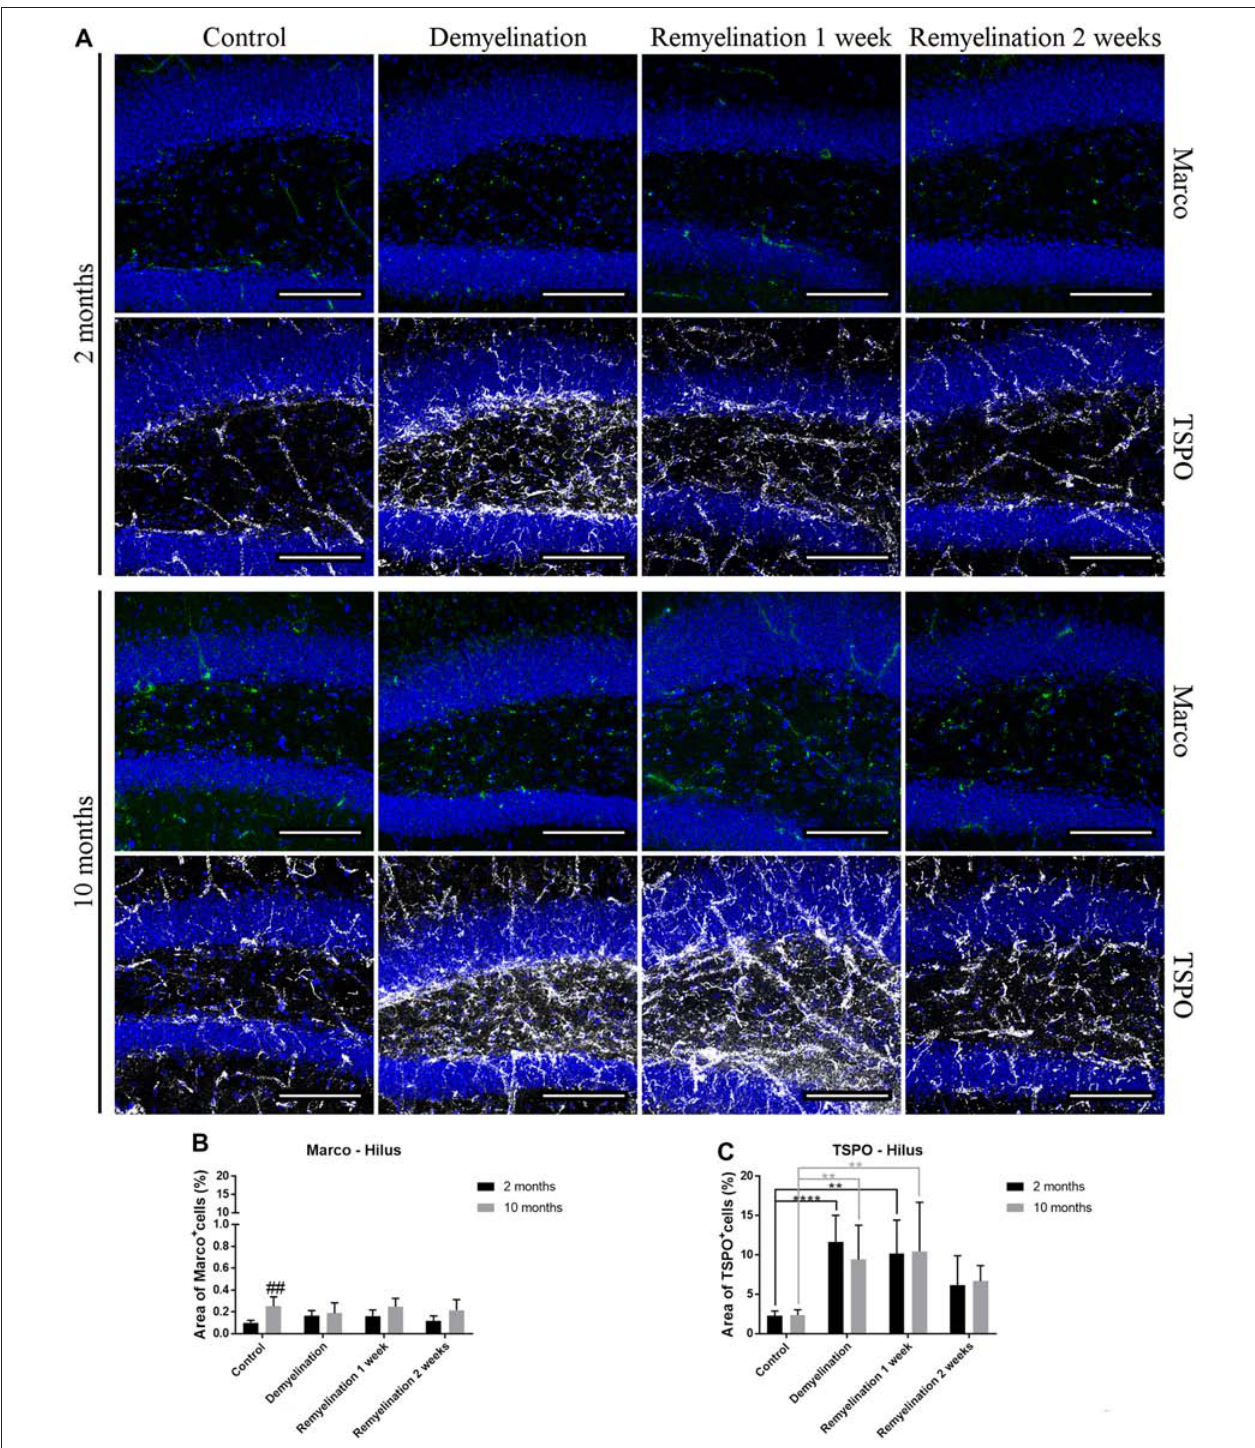
FIGURE 7 | Translocator protein 18 kD (TSPO), but not macrophage receptor with collagenous structure (Marco), reacts to de- and remyelination in the hilus of the hippocampal DG. (A) Marco (green) and TSPO (white) labeling. Cell nuclei are stained with DAPI (blue). (B) Marco staining was significantly higher in the middle-aged control group compared to the young one. De- and remyelination did not significantly change the levels of Marco. (C) TSPO was significantly increased during demyelination and the first week of remyelination in both age groups. Values are shown as means + SD ( n = 6 per group). Statistical significance was evaluated using a two-way ANOVA followed by a Tukey’s post hoc test (C) . The p -values are indicated in the graphs: treatment effects within the same age group: ∗∗ p < 0.01 and ∗∗∗∗ p < 0.0001, age-related differences: ## p < 0.01. Bars: (A) 100 µ m.